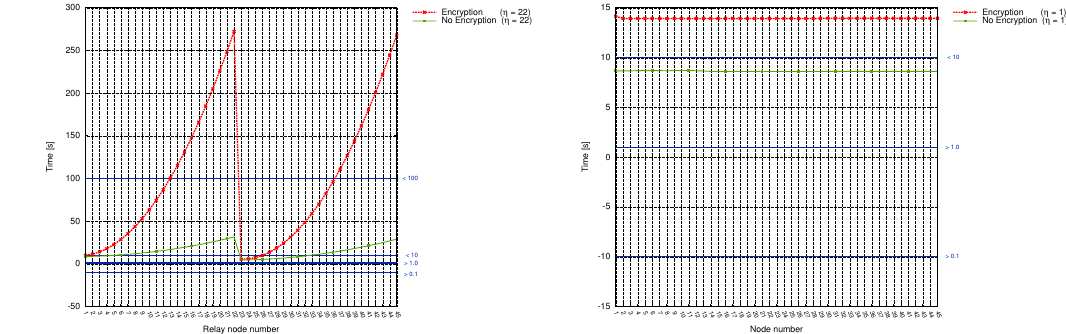
Figure 8. Scenarioss 1a,b, 2a,b: correlation between the sink number, time and power grid disturbance time frames (encryption/no